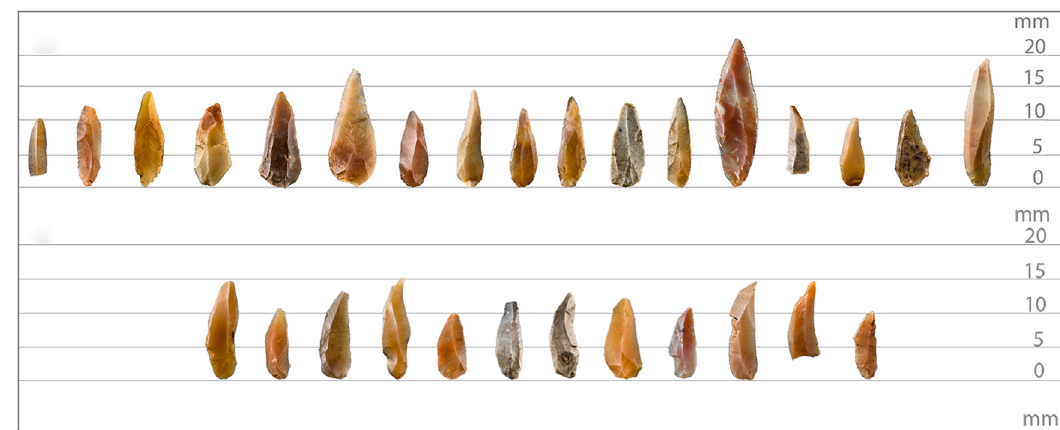
Figure 6: Areeiro 3: the Areeiro bladelets produced from carinated cores to be used as barbs for composite tools. Photo J. P.